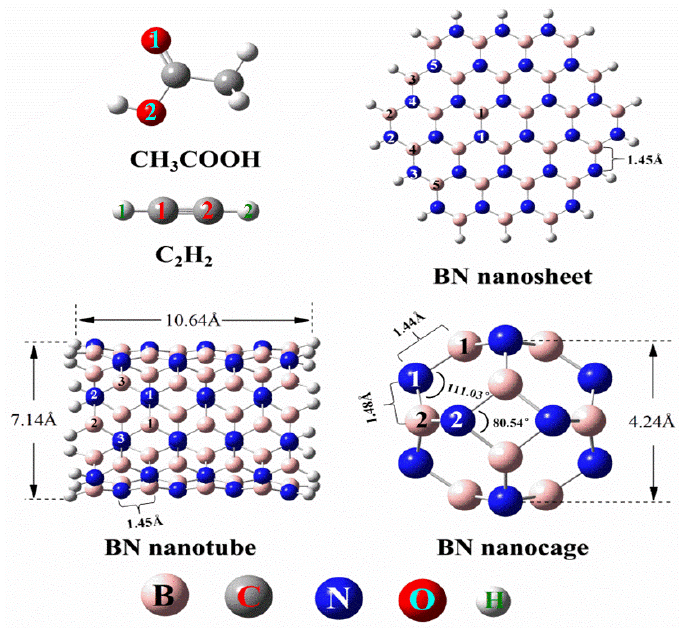
Figure 2. Optimized structures of C 2 H 2 , CH 3 COOH and BN nanosheet, BN nanotube, BN nanocage. (Pink is B atom, gray is C atom, blue is N atom, red is O atom, white is H atom)